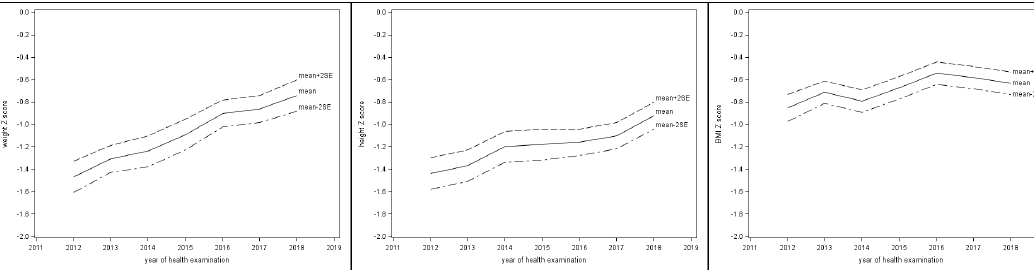
Figure 1. Serial plots of BW, BH, and BMI of randomly selected 50 sampled participants from 2012 to 2018, superimposed on the WHO standards (BW: body weight, BH: body height, BMI: body mass index).